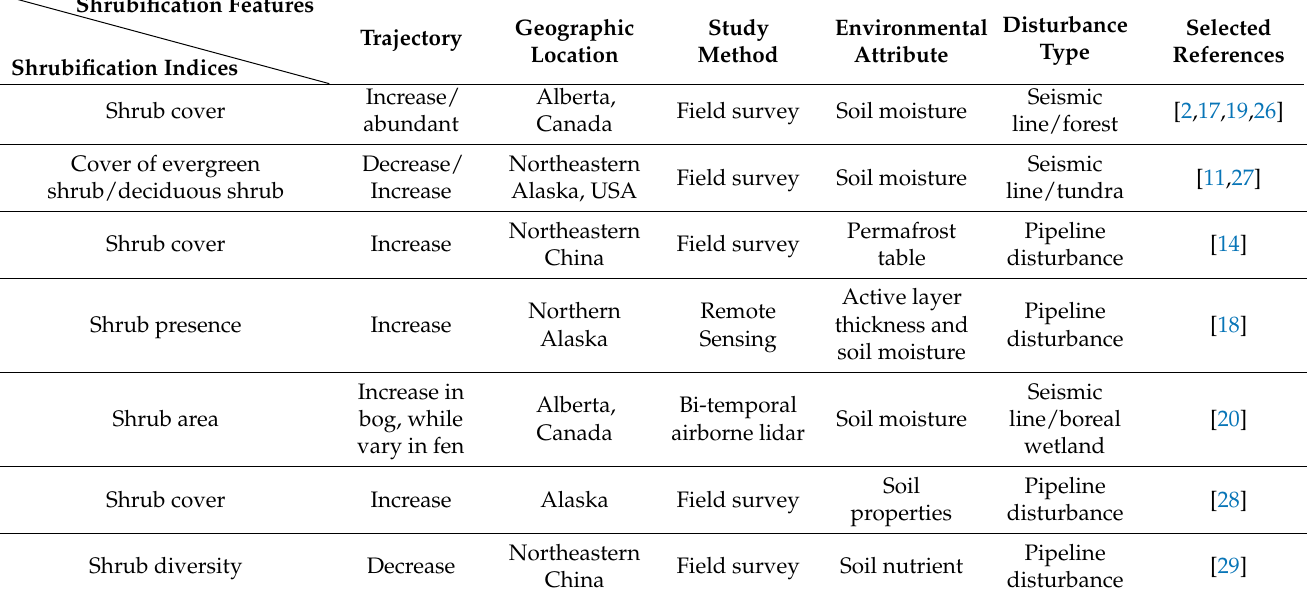
Table 2. Shrubification along pipeline corridors/seismic lines based on selected references published since